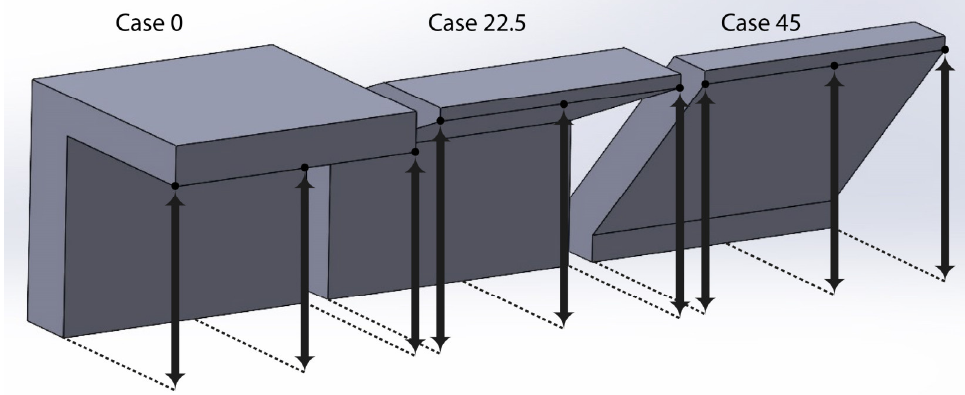
Figure 5. Reference points for evaluating warping deformation.